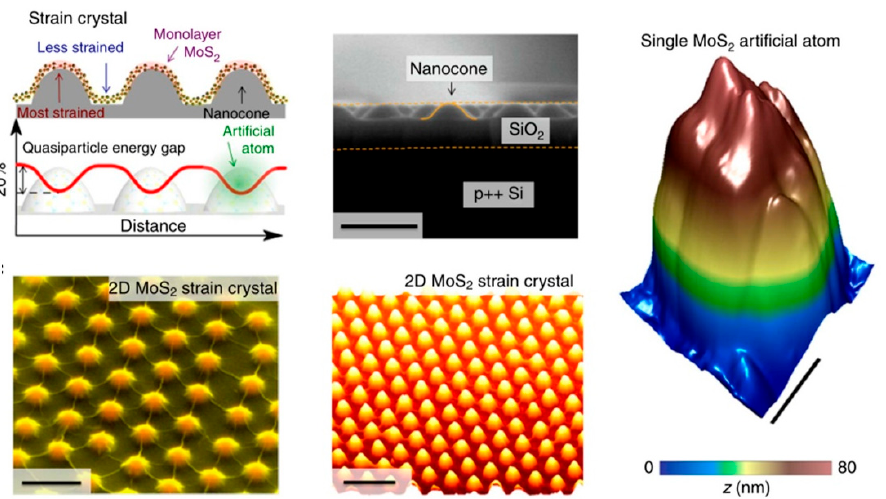
Figure 10. Assembly of an artificial-atom crystal via spatially patterned biaxial strain within a monolayer of MoS 2 . Reproduced with permission from [96] Copyright © 2021 Nature Publishing Group.